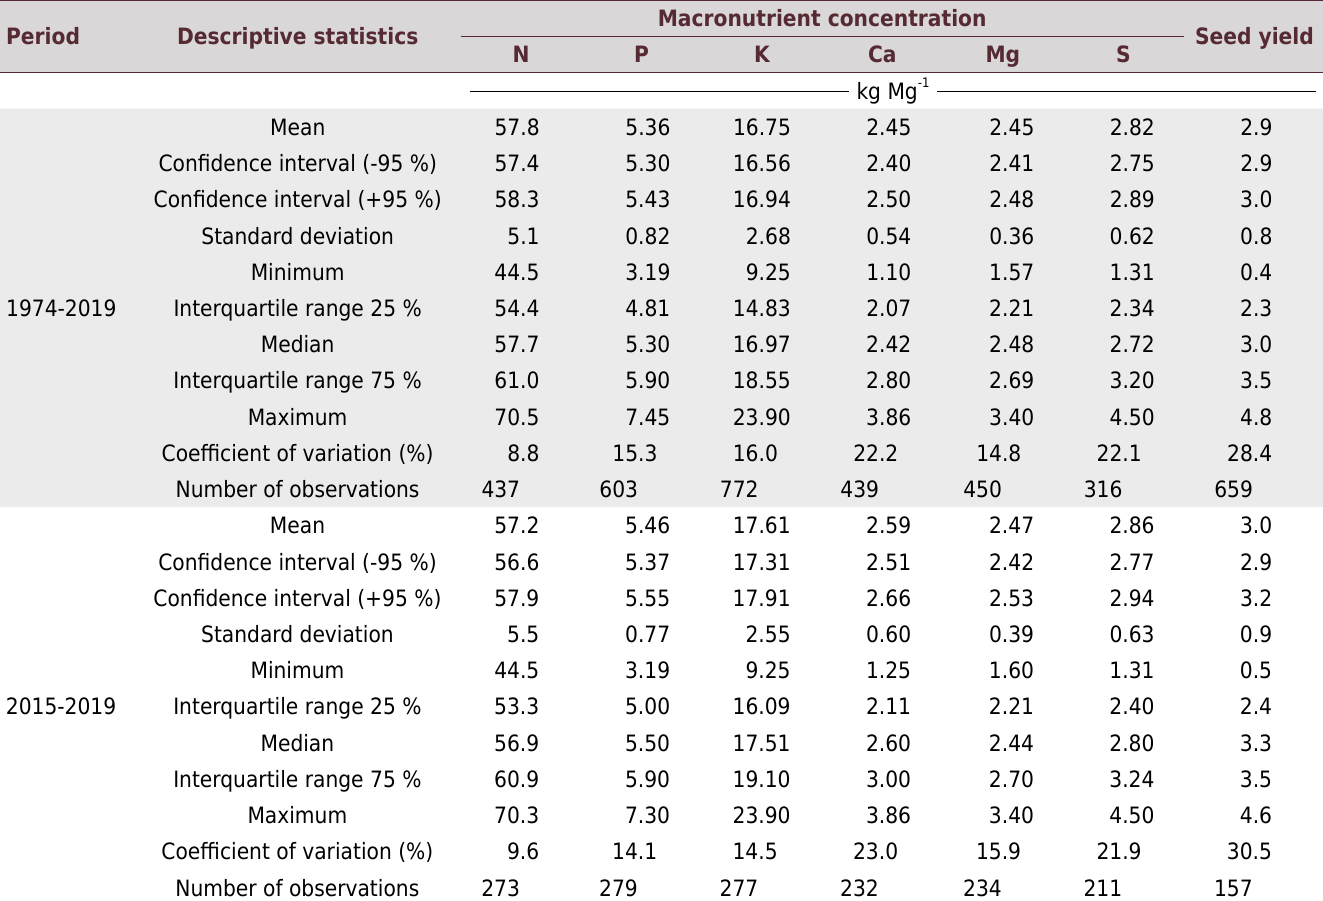
Table 1. Descriptive statistics for macronutrient concentration in soybean seeds in Brazil from 1974 to 2019 and from 2015 to 2019 Period